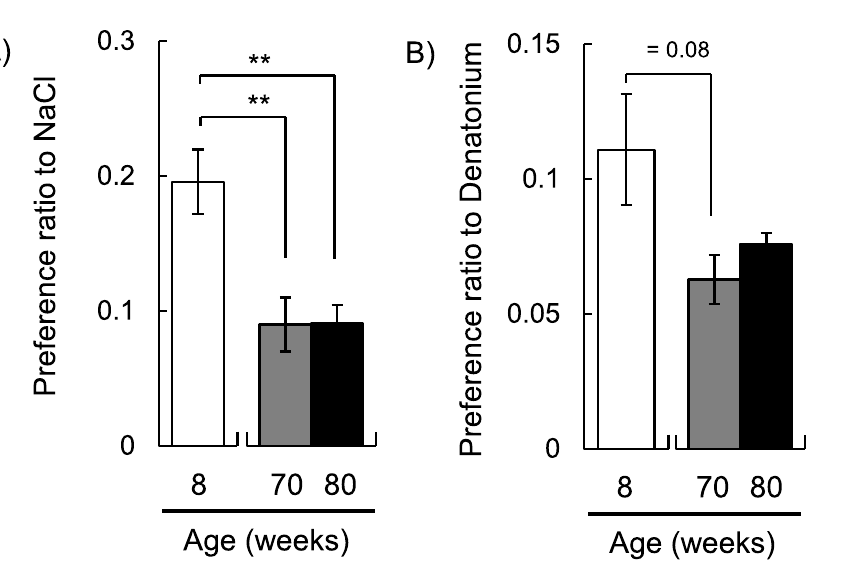
Fig 2. Taste sensitivity changes due to aging. The preference ratios for (A) salty (300 mM of NaCl) and (B) bitter taste (1 mM of denatonium) to water are shown (8-week-old mice for n = 24–25, 70-week-old mice for n = 19, 80-week-old mice for n = 13). The preference ratio to NaCl significantly decreased with age ( F (2 , 54) = 8.34, p < 0.001; one-way ANOVA). The preference ratio to denatonium tended to decrease with age (F ANOVA). �� p < 0.01 (Tukey posthoc